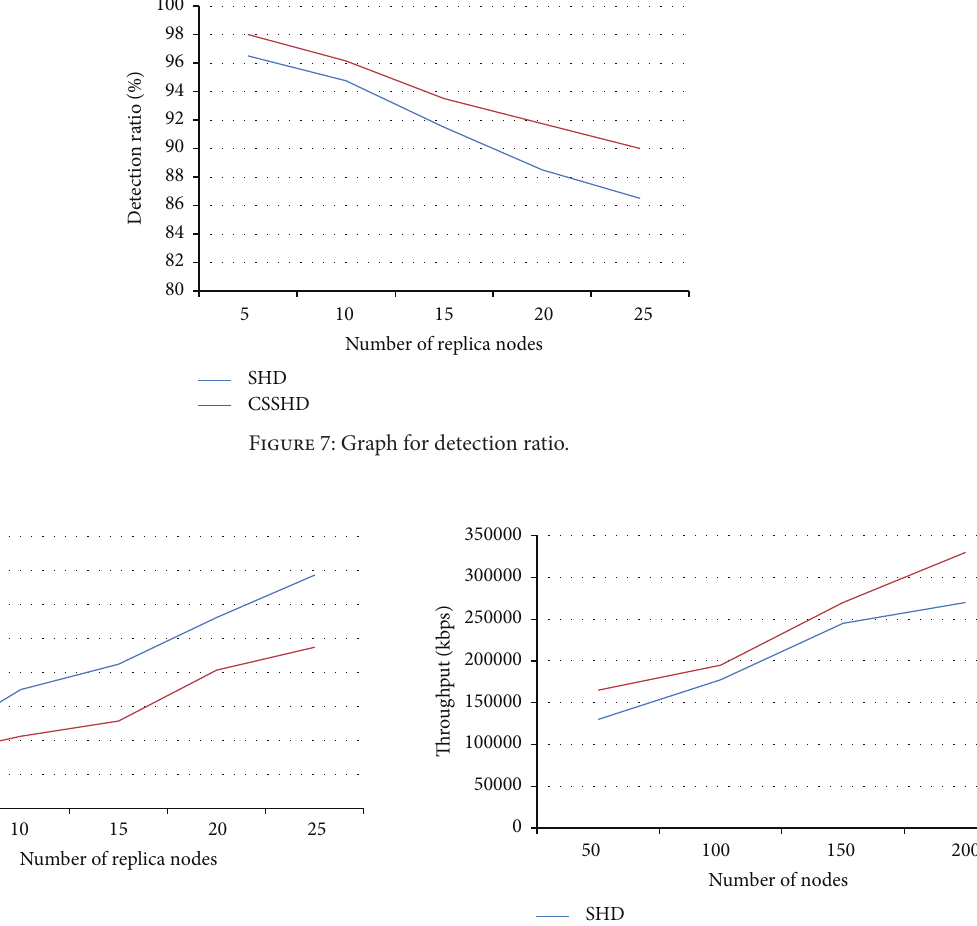
Figure 8: Graph for false alarm rate.